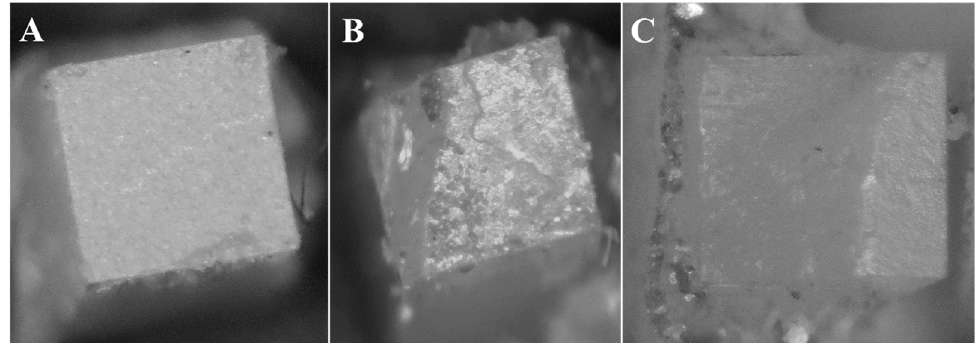
Figure 4. Representative stereomicroscope images for the different failure modes (40×). ( A ) Adhesive failure mode. ( B ) Mixed failure mode. ( C ) Cohesive mode of failure.